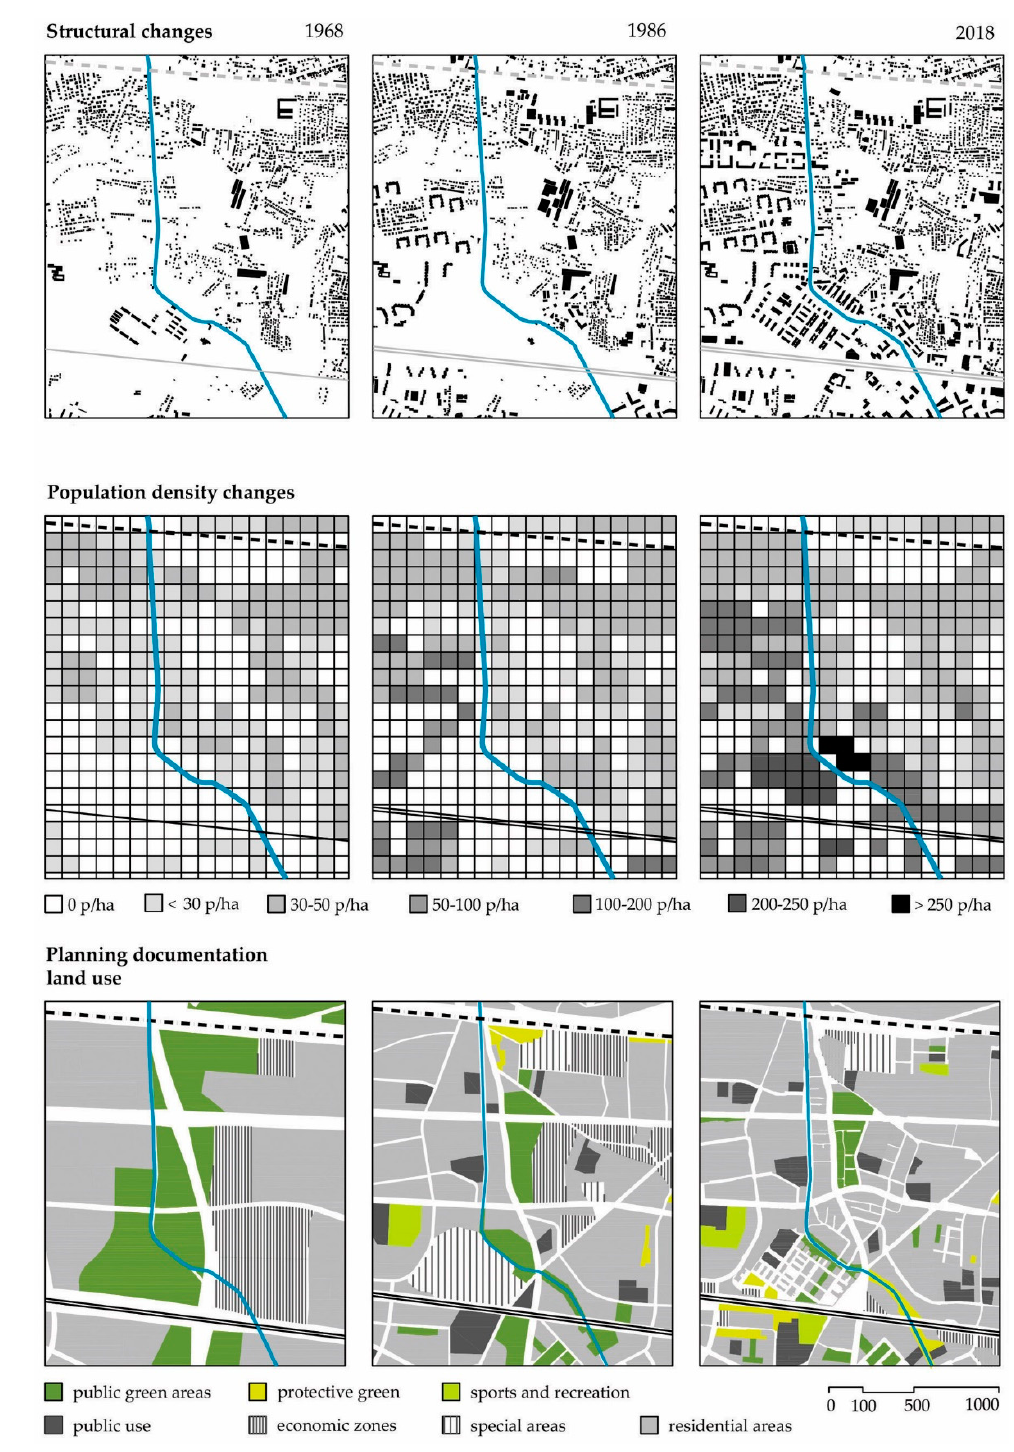
Figure 5. Urban landscape features along the Vrapˇcak stream. Source: Authors. Table 4. The share of green areas along the Vrapˇcak stream. Source: